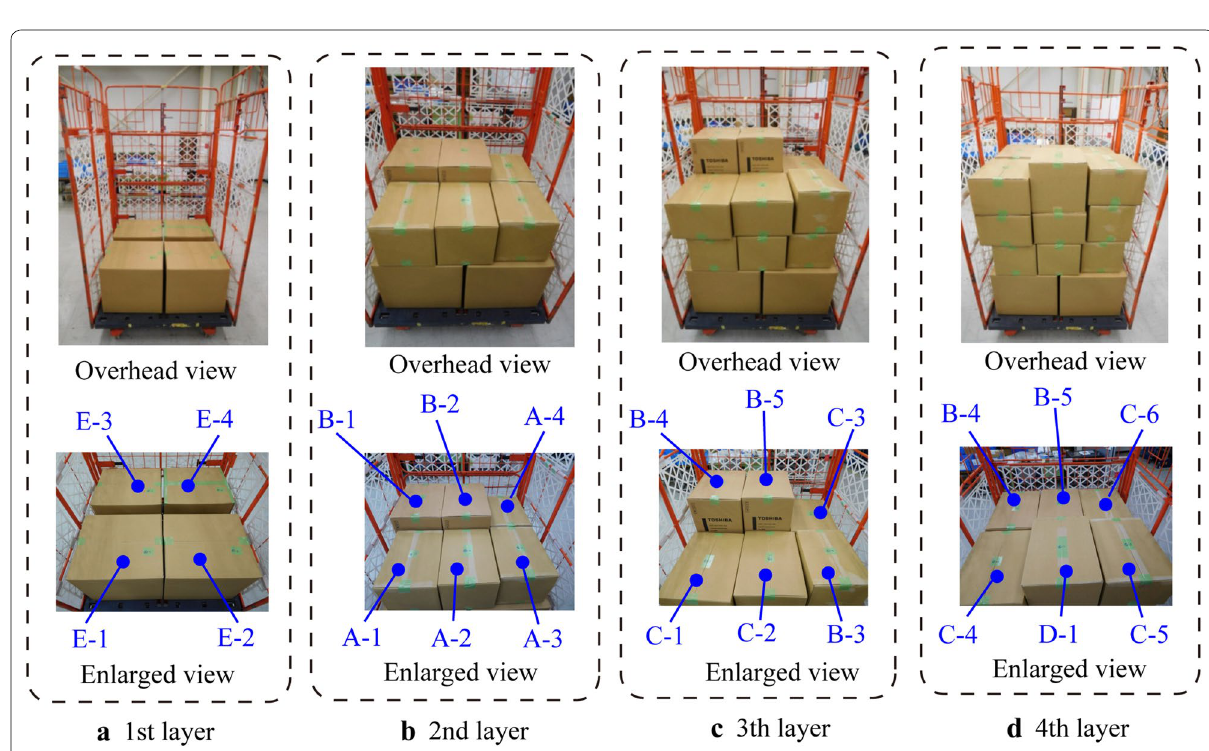
Fig. 33 Loading pattern for cardboard